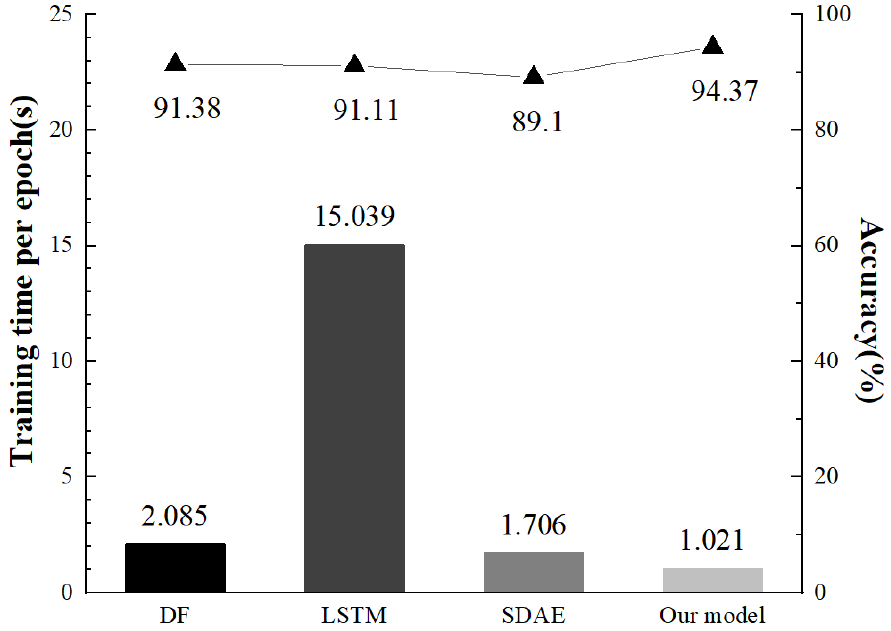
Figure 14. Training time and accuracy on different models.